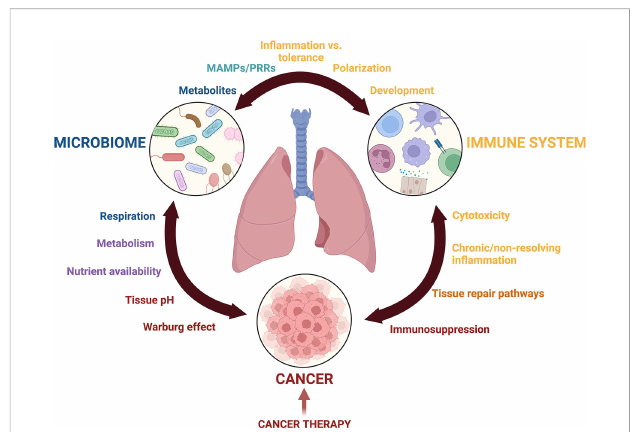
FIGURE 1 Crosstalk among the lung microbiota, pulmonary immune system, and the lung cancer microenvironment is complex. Communication mediated by metabolites, microbial associated molecular patterns (MAMPs), pattern recognition receptors (PRRs), in fl ammatory mediators, growth factors, and nutrient availability drives changes to Microbial diversity, in fl ammation, and potentially cancer development and progression. The balance of these interactions is further complicated by cancer treatments including immunotherapy, radiation, and chemotherapy. This fi gure was created with